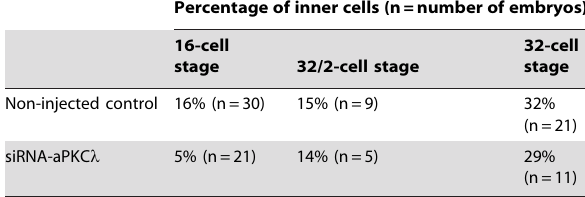
Table 4. Cell allocation in embryo halves.